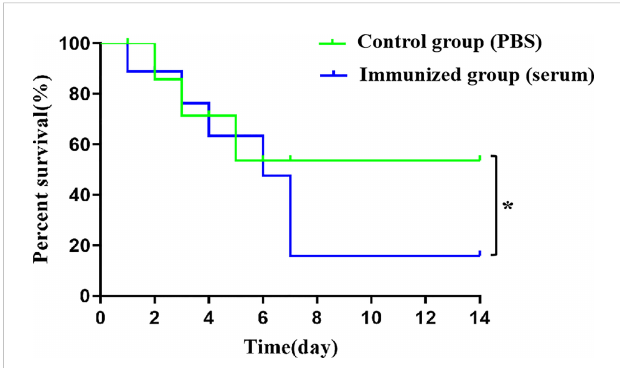
FIGURE 7 Intraperitoneal injection of antiserum improves death rate in challenge SS9-P10. Kaplan-Meier survival curves of immunized mice with SS9- P10 infection. Were monitored daily for 2 weeks. The statistical signi fi cance was analyzed by log-rank (Mantel-Cox) test (n=8, *P <0.05